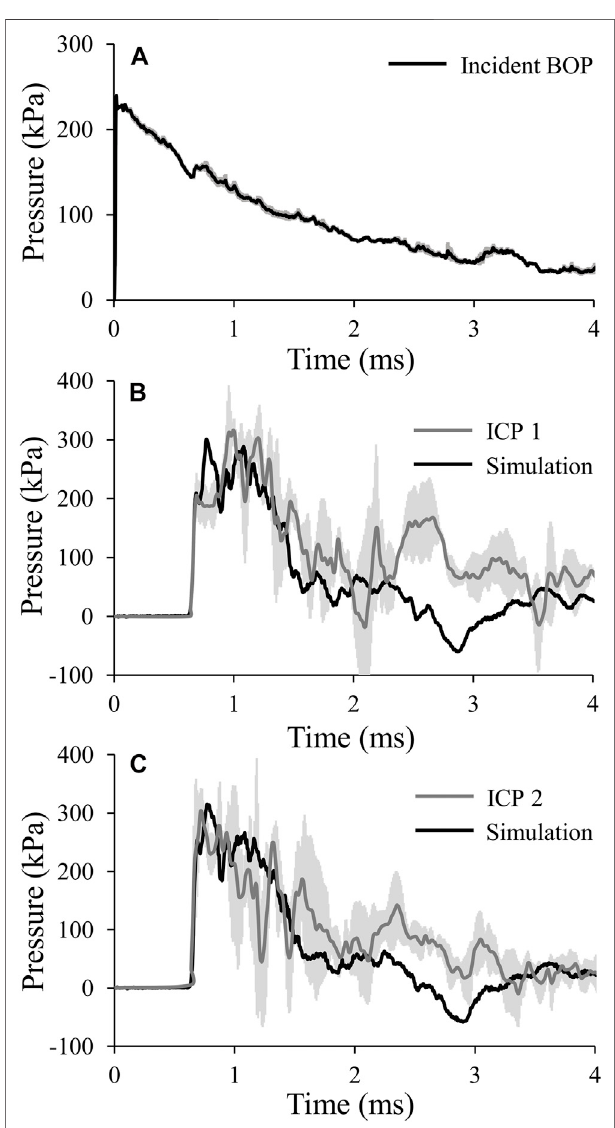
FIGURE 3 | (A) Temporal pro fi le of the incident blast overpressure (BOP). The solid line and shaded area represents the mean ( n (cid:1) 6) and two standard errors of the mean (SEM), respectively. (Because the SEM are small, they may not be visible.) (B) and (C) Comparison of the pressures predicted by the fi nite-element model of the minipig head with vasculature (black lines) with those obtained from the experimental studies (gray lines) for intracranial pressure 1 (ICP 1; B) and intracranial pressure 2 (ICP 2; C). The gray lines and shaded areas represent the mean (n (cid:1) 4) and two SEM,